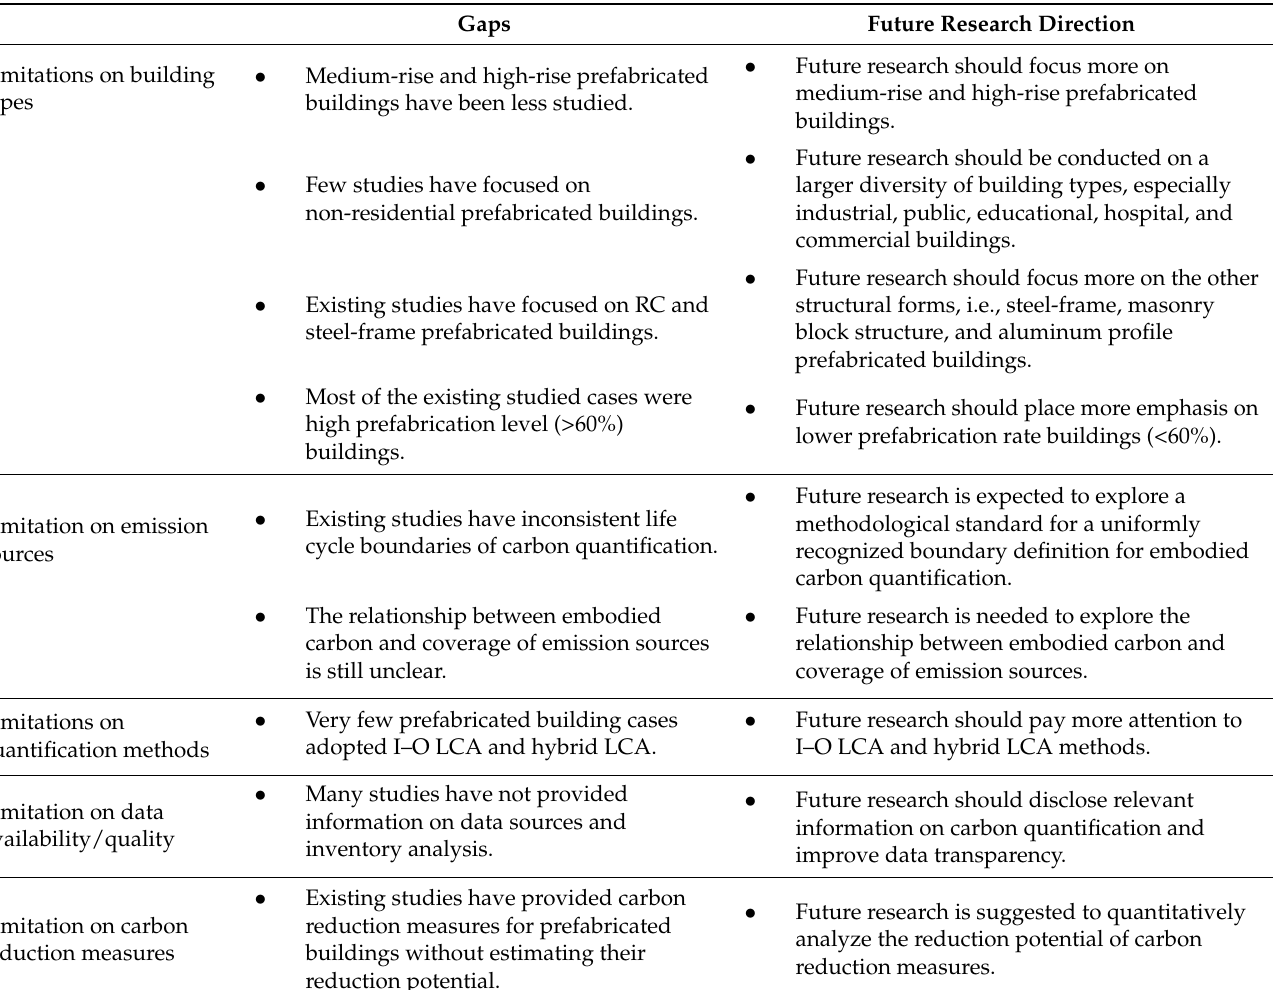
Table 5. Knowledge gaps and future research directions in embodied carbon quantification of prefabricated